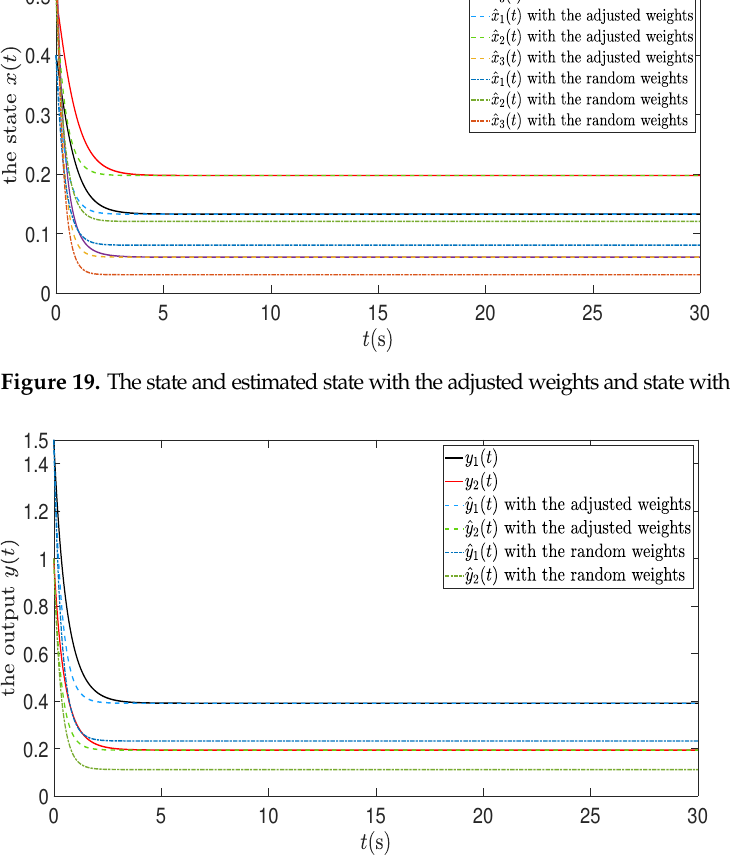
Figure 20. The output and estimated output with the adjusted weights and output with the random weights